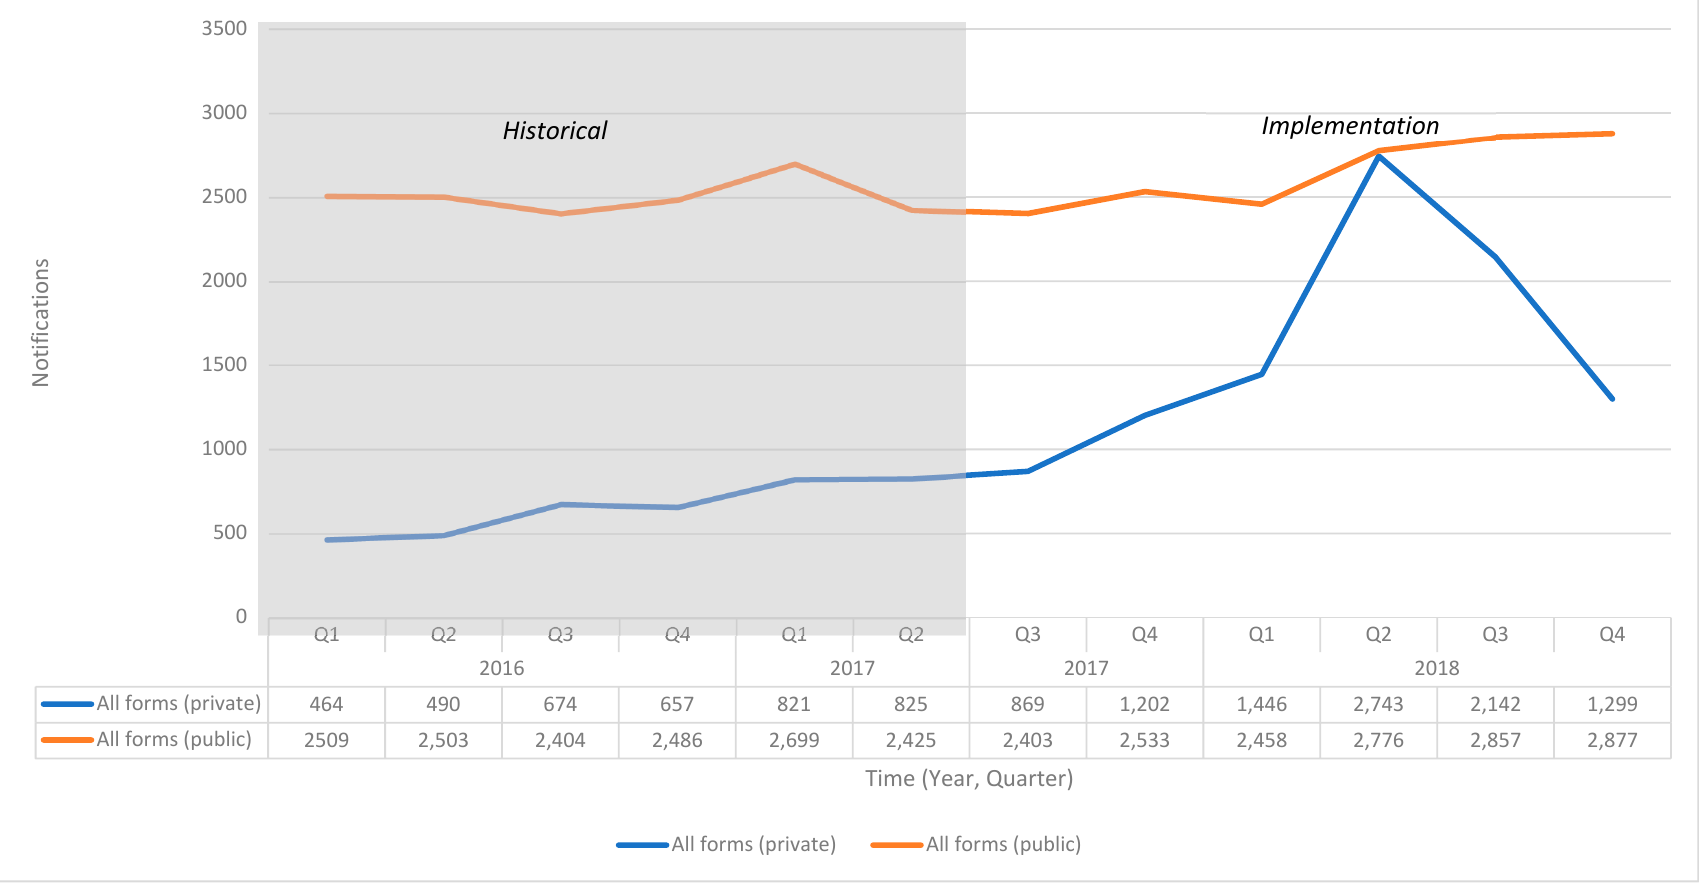
Figure 2. Graph of the notifications in the National TB Elimination Program in the private project intervention area between January 2016 and December 2018.